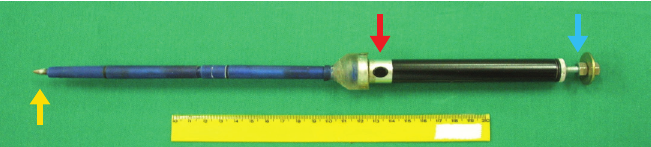
FIGURE 1 - Device used to promote the spleen injury. Steel blade end point (yellow arrow). Trigger (red arrow). Bar to arm the internal spring (blue